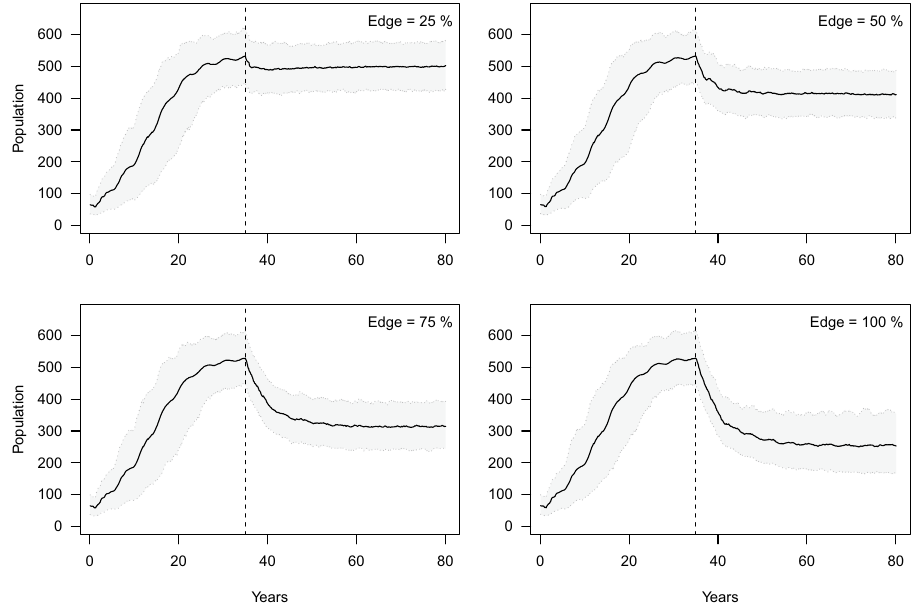
Figure 1. Effect of hunting (annual hunting quota = 18 males ≥ 6 years) and conflict (0.4% monthly mortality rate) on lion population persistence with varying edge effects (% of prides exposed to conflict and hunting; see Figure S4). The continuous black line represents the mean and the light grey area the 95% confidence interval. The vertical dotted line marks the point at which test scenarios were implemented after the population had reached its asymptotic